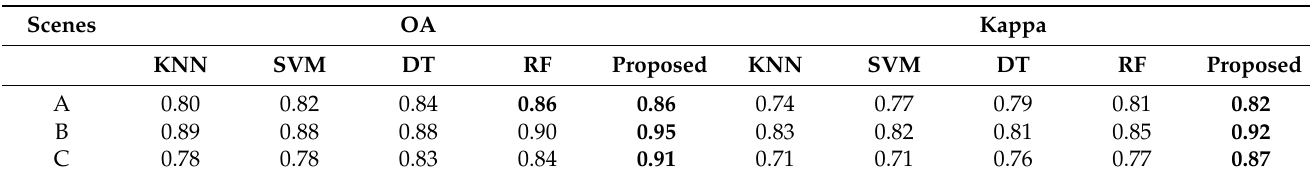
Table 3. Comparison of OAs and Kappas using the KNN, SVM, DT, RF, and proposed methods for experimental scenes A, B, and C. Bold represents the highest precision of a same class among these methods.